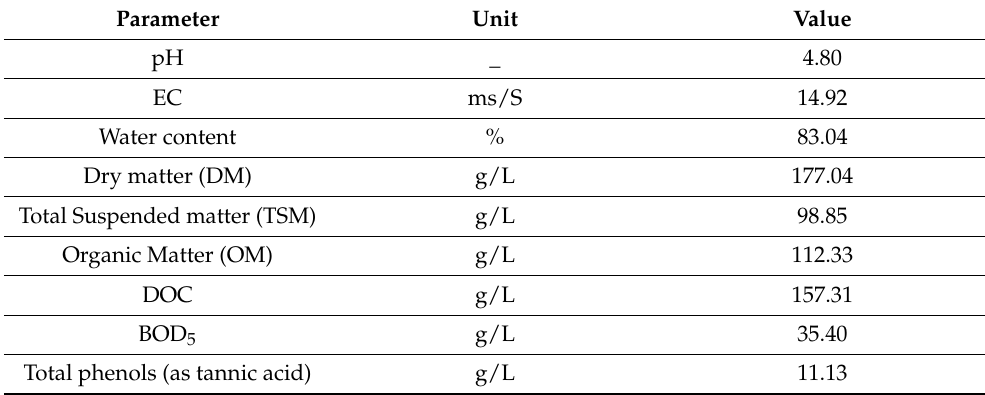
Table 1. Physicochemical characterization of